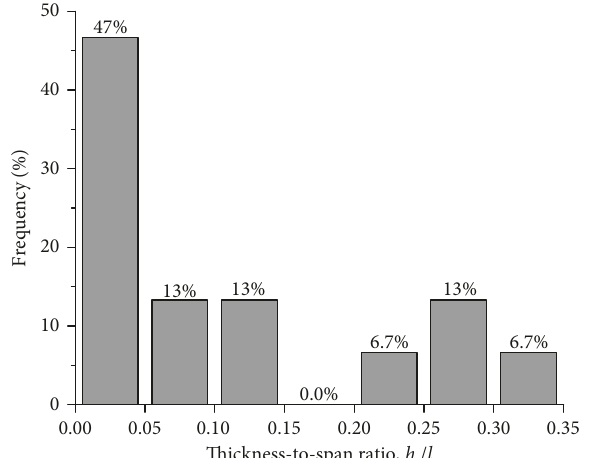
Figure 17: Frequency distribution of the thickness-to-span ratio.